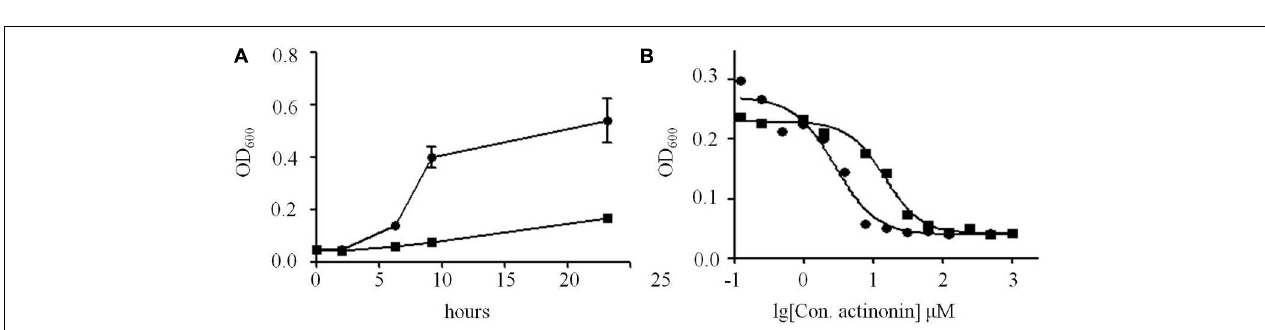
FIGURE 5 | Proliferation differences between V. anguillarum mutant and wild type strains. (A) Growth of V. anguillarum mutants and wild type strains in MH broth, measured as optical density at 600 nm. (B) MIC tests of actinonin on V. anguillarum mutants and wild type strains. Solid circle, wild type strain; solid square, mutant